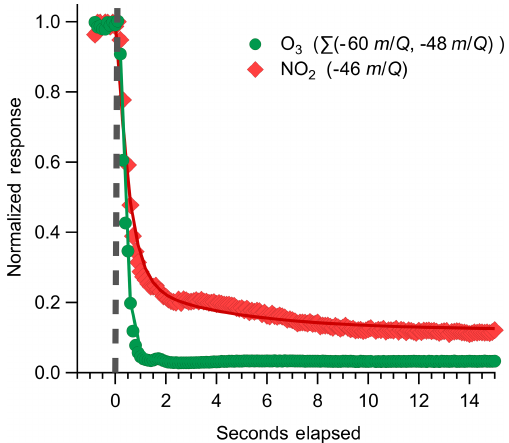
Figure 5. Normalized count rate of CO − ( − 60 m/Q ) ozone detec- Figure 6. Representative instrument backgrounding determination 3 tion product as a function of pressure in the IMR during sampling for O 3 and NO 2 , where the inlet was rapidly switched from ambient of a constant 35ppbv O 3 source. The exponential fit of the data sampling to an overflow with dry UHP N 2 indicated by the dashed is shown by the dashed line. Fit parameters are included to allow grey line. The O 3 response is fit to an exponential decay, plotted for calculation of potential sensitivity improvements with further as solid lines, with a mean response time of 0.28s; NO 2 is fit to a increases in IMR pressure. biexponential decay, where the initial rapid decay ( τ 1 ) is attributed to gas evacuation of the inlet line and the second slower decay ( τ 2 ) is attributed to equilibration with the inlet walls. Best-fit estimates for τ 1 of NO 2 are from 0.7 to 1.2s. τ 2 for NO 2 was determined to be 3.2s for this decay